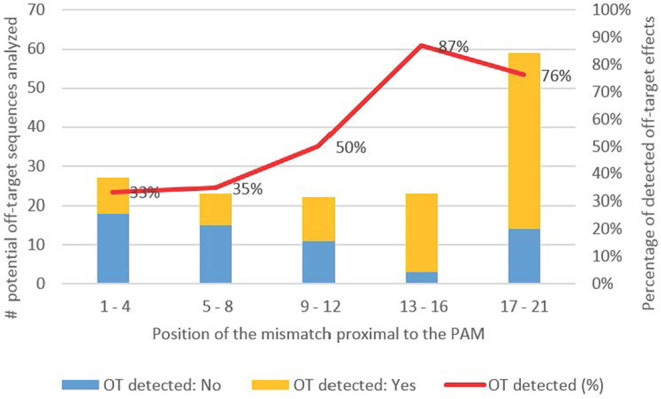
Percentage of detected off-target effects for one mismatch based on the position the mismatch is located proximal to the PAM. The guide sequence is divided in five intervals of four nucleotides each (Position 1–4 proximal to the PAM, position 5–8, 9–12, 13–16, 17–21. Yellow: Number of studies with detected off-target effects; blue: Number of studies without detected off-target effects; Red: Percentage of detected off-target effects for each interval.